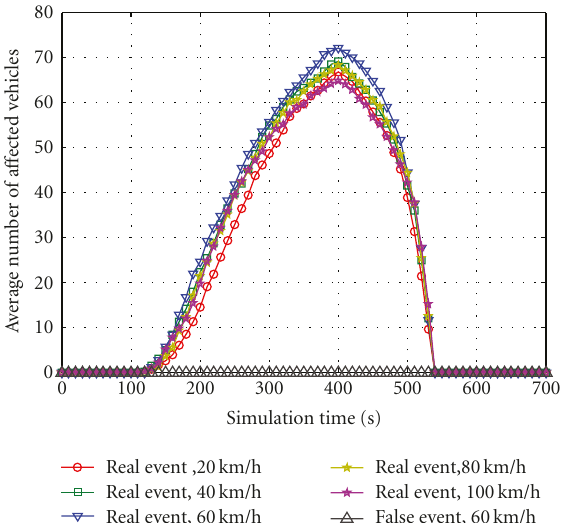
Figure 11: The comparison of the number of a ff ected vehicles between a real event and a false